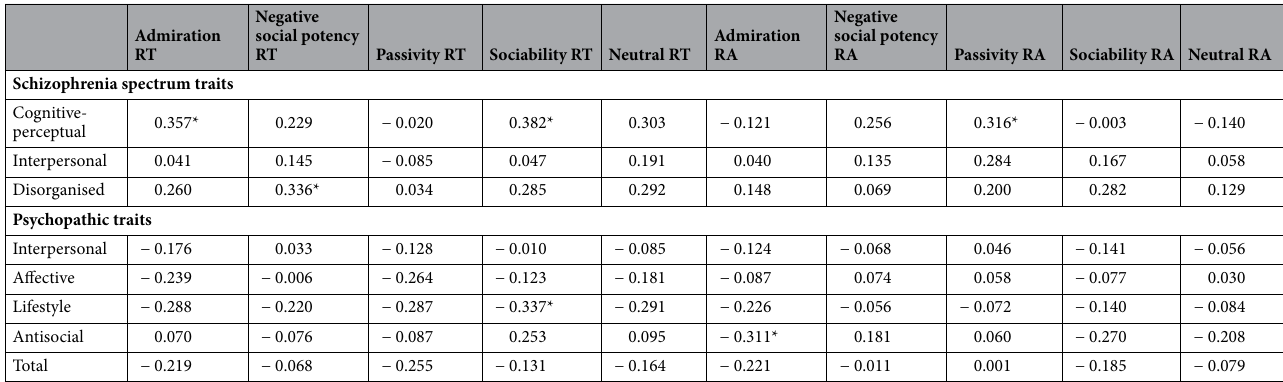
Table 3. Correlations between SRS-IDT performance and schizotypy and psychopathy dimensions. RT reaction time; RA response accuracy. *Significant at p = 0.05.